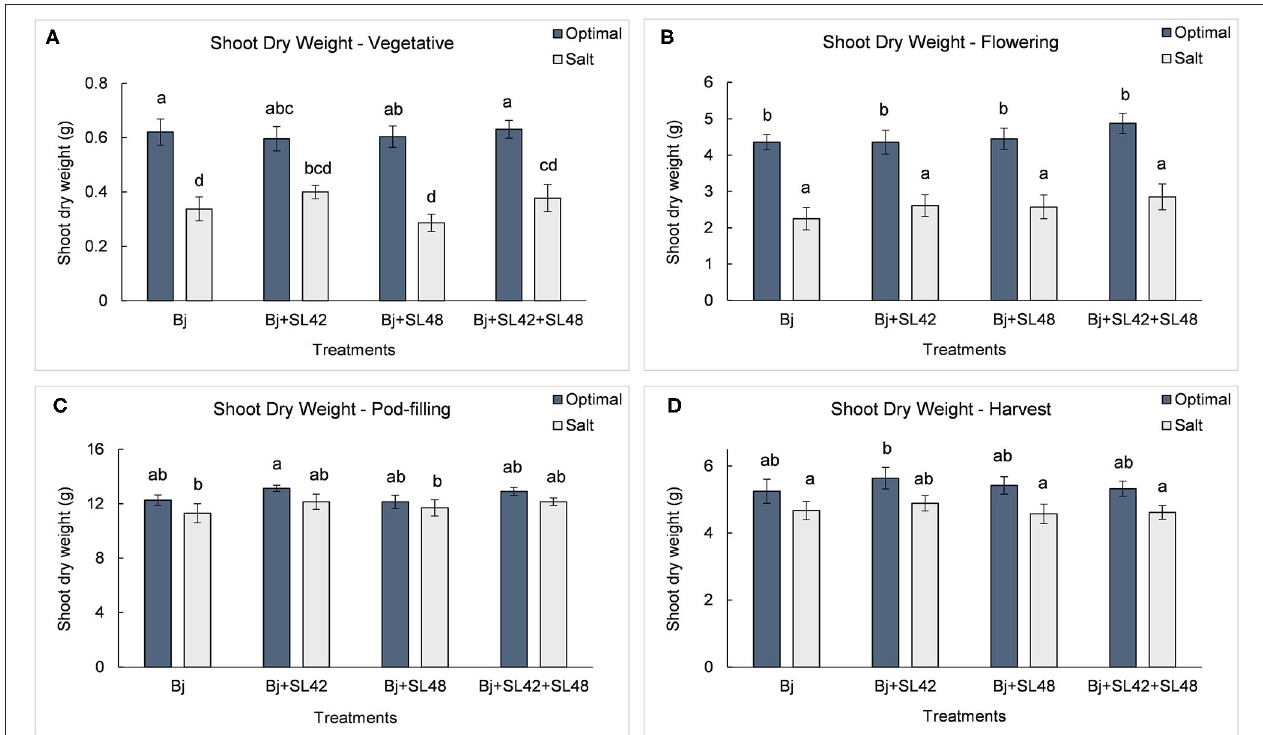
FIGURE 8 | Shoot biomass of soybean plants measured at (A) mid-vegetative, (B) mid-flowering, (C) mid-pod-filling, and (D) harvest stages under optimal (water) and salt (150mM NaCl) conditions. The seeds were bacterized with Bradyrhizobium japonicum (Bj), Bj + SL42, Bj + SL48, and Bj + SL42 + SL48. Values represent mean ± SE ( n = 12). Scheffe grouping for least square means was used for multiple means comparison and means with the same letter(s) are not significantly different ( α =